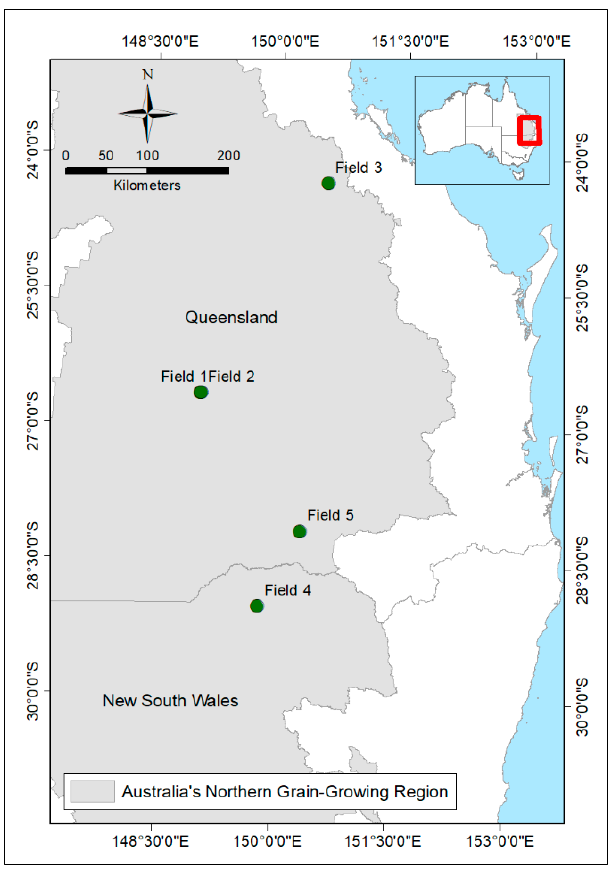
Figure 1. The study area in Australia’s northern grain-growing region, and the five fields considered in this analysis.